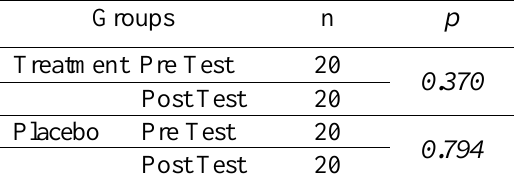
Table 3. Wilcoxon Smith Test (The Pre Test- Post Test of Treatment and Placebo